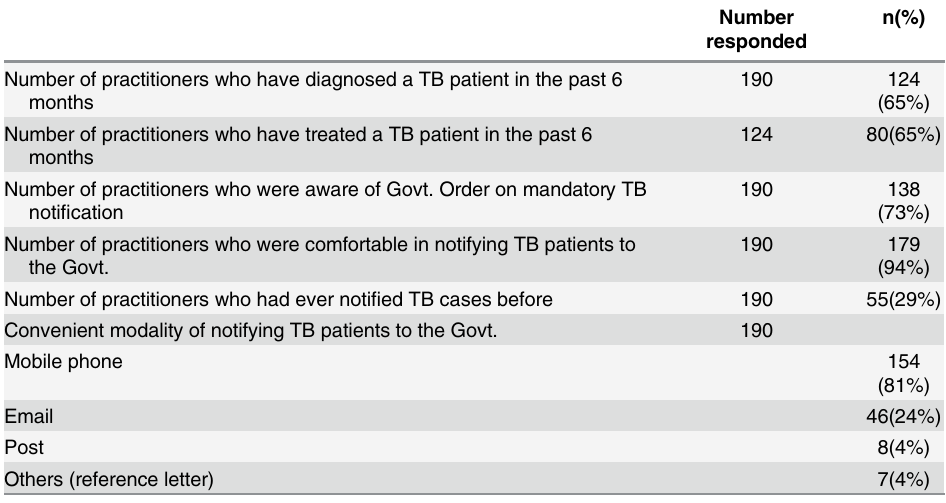
Number n(%) responded 190 124 (65%) 124 80(65%) 190 138 (73%) 190 179 (94%) (81%)